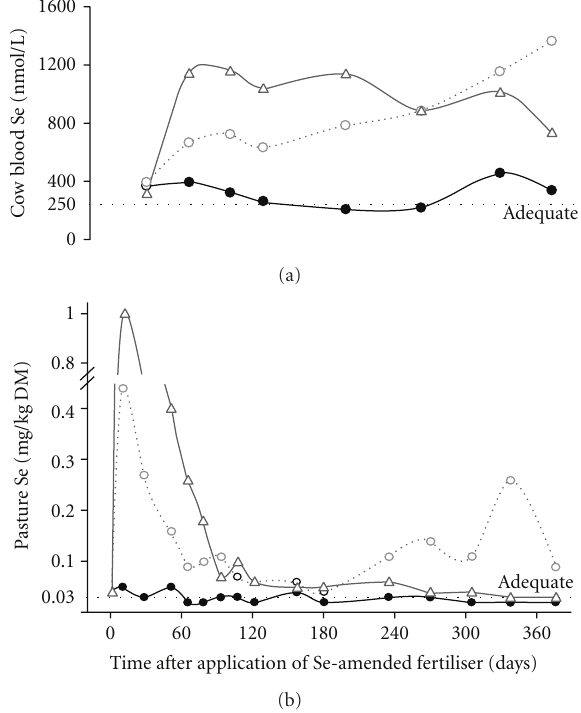
Figure 9: E ff ect of none ( • ) or 10g Se/ha as sodium selenate ( (cid:4) ) or sodium selenate plus barium selenate ( (cid:2) ) applied to pastures grazed by dairy cows on the concentrations of Se in (a) blood, and (b) pasture herbage. Adequate Se status is indicated by blood Se > 250nmol/L and herbage Se > 0.03mg/kg DM